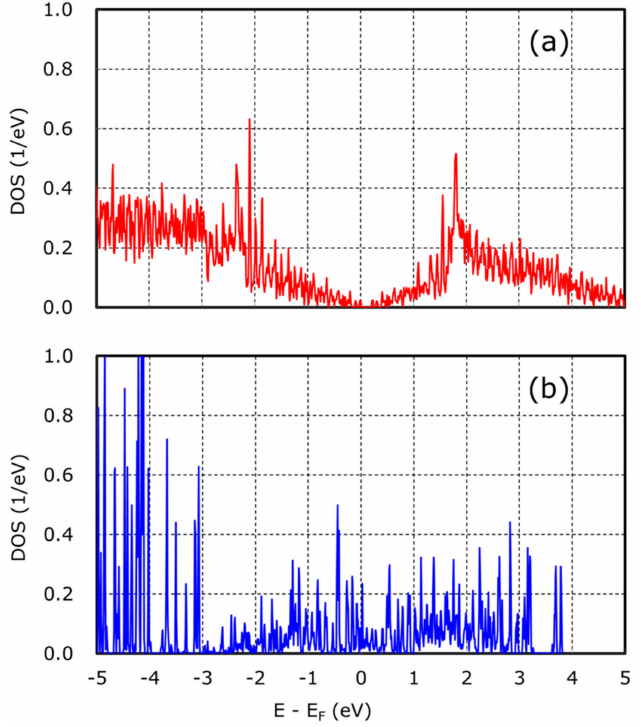
Figure 7. DOS of ( a ) graphene, and ( b ) graphene with